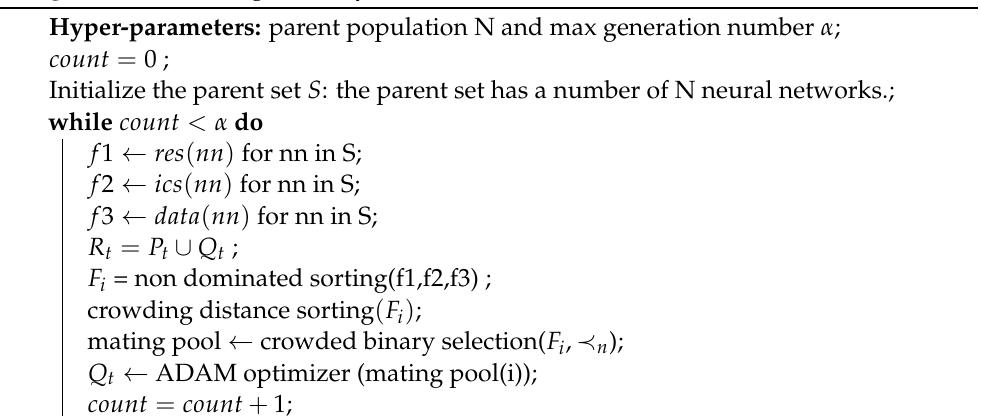
Algorithm 3: Training PINN by NSGA-PINN